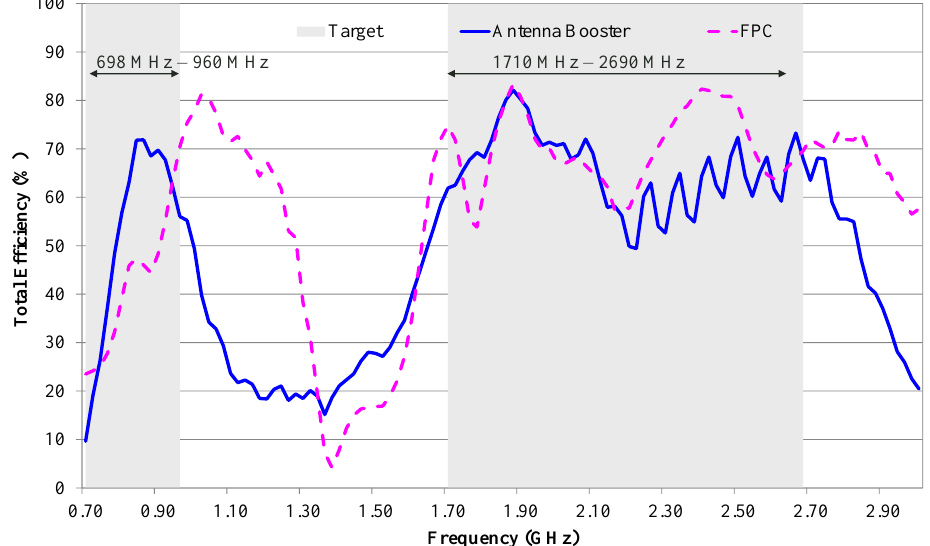
Figure 3. Measured total efficiency for the embedded antenna booster and the FPC.